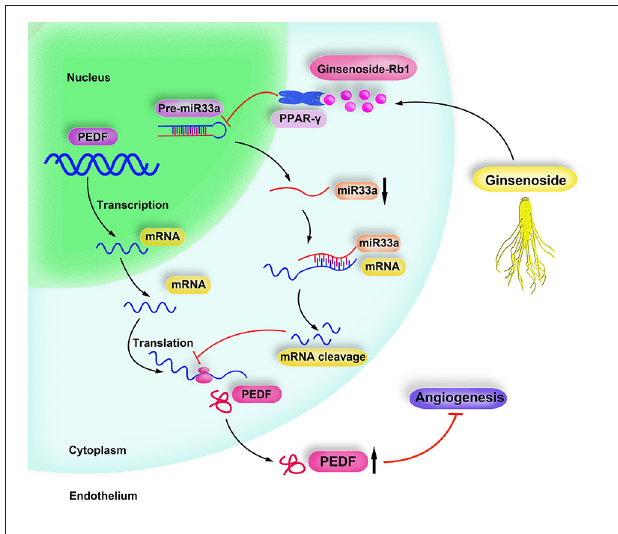
FIGURE 5 | Schematic diagram of Rb1 inhibiting angiogenesis. Ginsenoside Rb1 suppresses miR-33a expression via activating PPAR γ , leading to increment of PEDF expression, thereby inhibiting